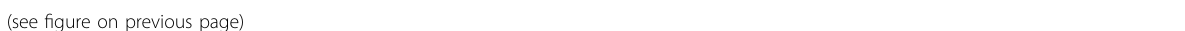
Fig. 6 Haloperidol treatment rescues night-time activity under light – dark conditions in Rim mutants. A Newly eclosed fl ies were fed with the antipsychotic drug haloperidol (1 mM) for 4 days prior to and then continuously throughout the behavioural test. Animals were entrained for 2 full days in 12:12 LD cycles, followed by 3 days on LD where locomotor circadian activity was measured (red box). B Averaged normalized activity pro fi les of w 1118 fed with normal or 1 mM haloperidol-supplemented food (black and grey line, respectively) and Rim Ex98 fed with normal or 1 mM haloperidol-supplemented food (red and orange, respectively) are shown. Grey background shading represents dark period (i.e., night-time) while white background segment represents the light phase (i.e., day-time). Morning and evening anticipation are indicated with blue and green arrowheads, respectively. C Day-time activity was not different in Rim Ex98 as compared to control fl ies; however, haloperidol treatment increased day- time activity in mutants, an effect that is not observed in control fl ies. D Night-time activity is reduced in Rim Ex98 as compared to control fl ies. The de fi cit observed in mutant animals is reversed by 1 mM haloperidol treatment with no effect observed in control fl ies. E Morning anticipation, calculated as the difference between the averaged activity in ZT21.5 – 24 and ZT17 – 19.5, is decreased in Rim Ex98 fl ies regardless if fl ies are treated or not with haloperidol. F Evening anticipation, calculated as the difference between the averaged activity in ZT9.5 – 12 and ZT5 – 7.5 58 , is not different in Rim Ex98 mutants compared to control fl ies. Feeding fl ies with haloperidol increases the evening anticipation in mutants while no changes are observed in control fl ies under the same conditions. Data were analysed using two-way ANOVA followed by Sidak ’ s multiple comparison test.